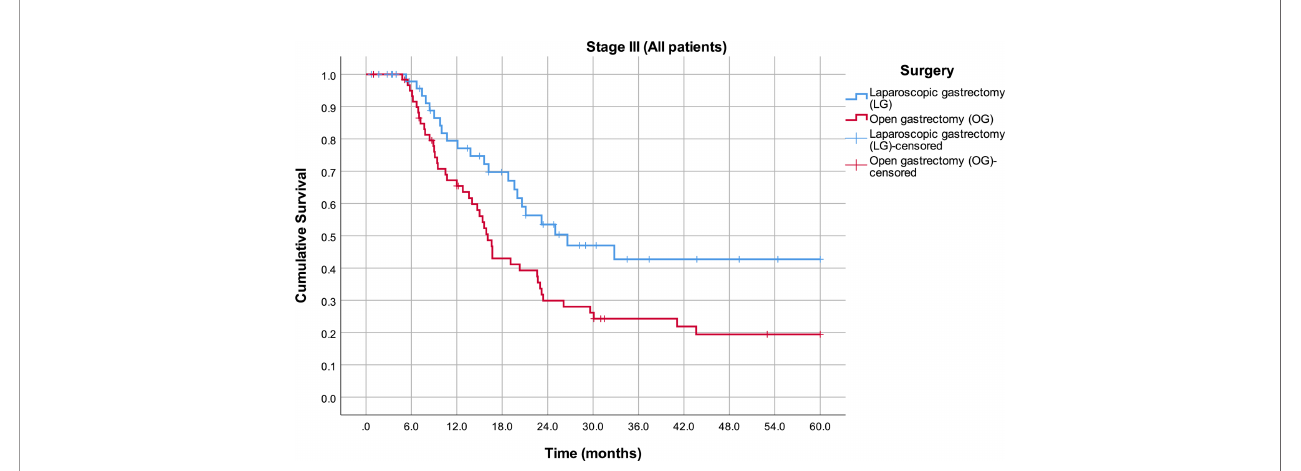
FIGURE 3 | Estimated mean survival for the patients in stage III disease, in respect to the operative approach.